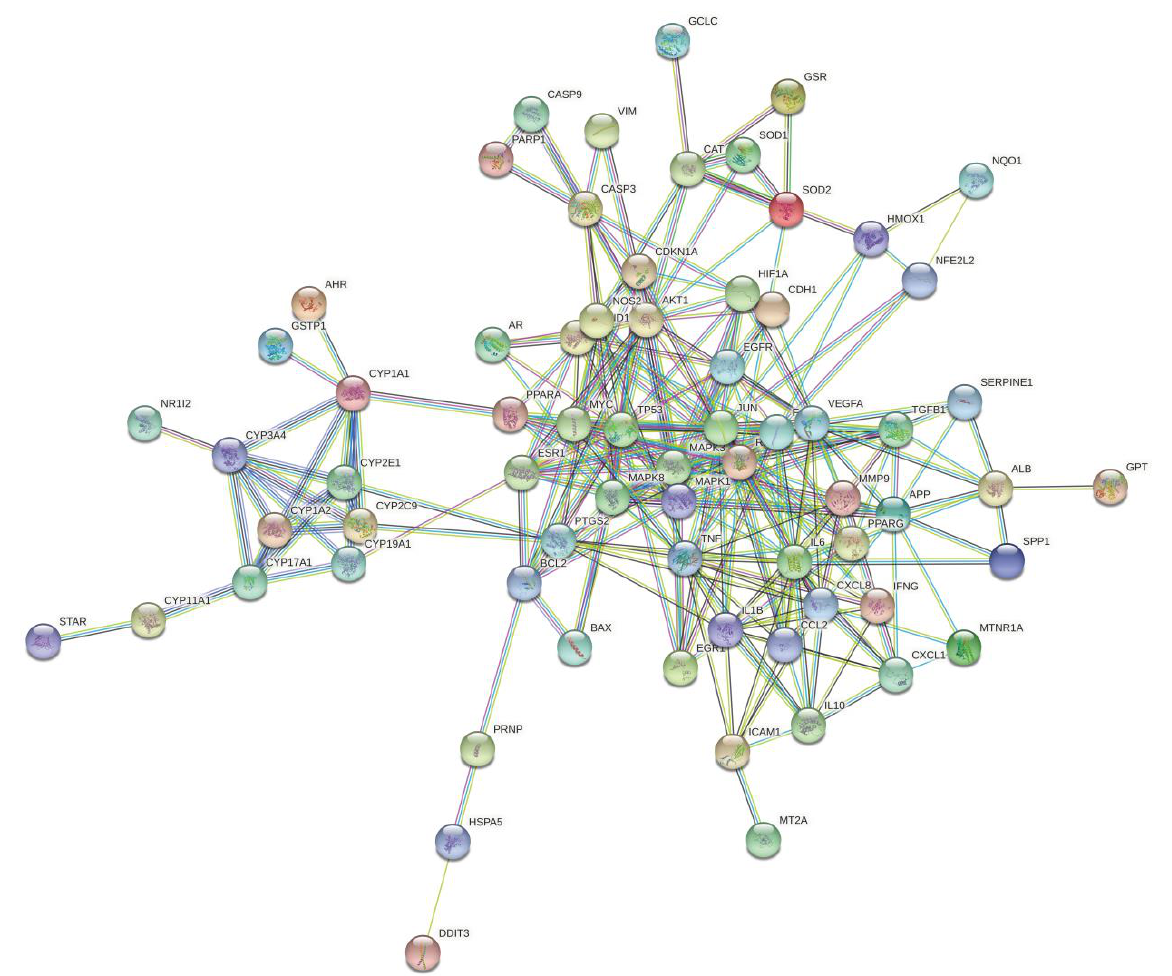
Figure 3. Construction of the PPI network and hub genes identified.